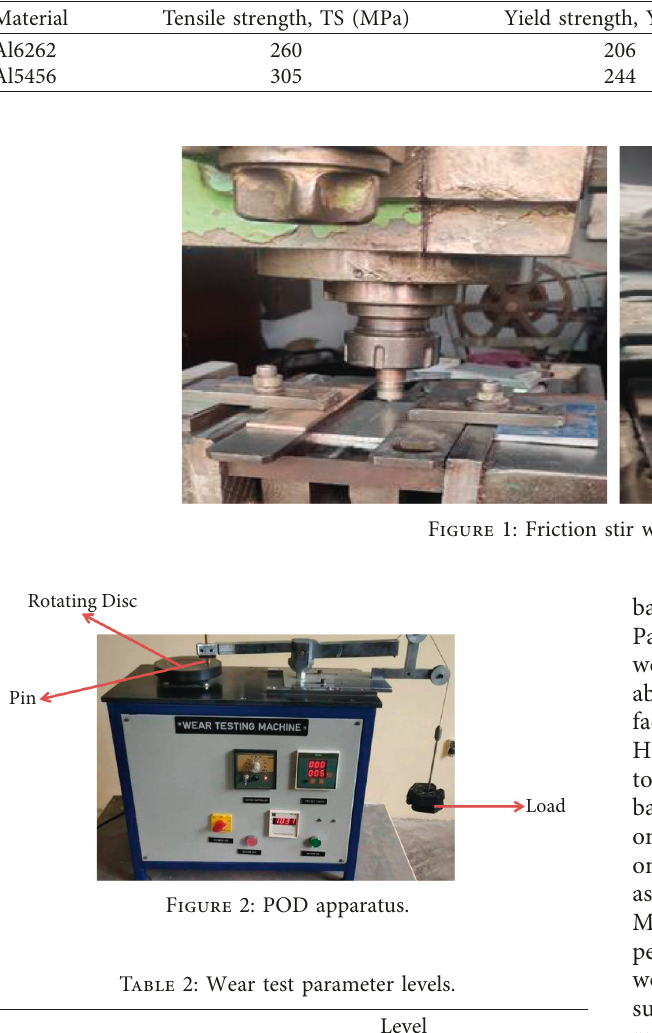
Table 1: Mechanical properties of Al6262 and Al5456.